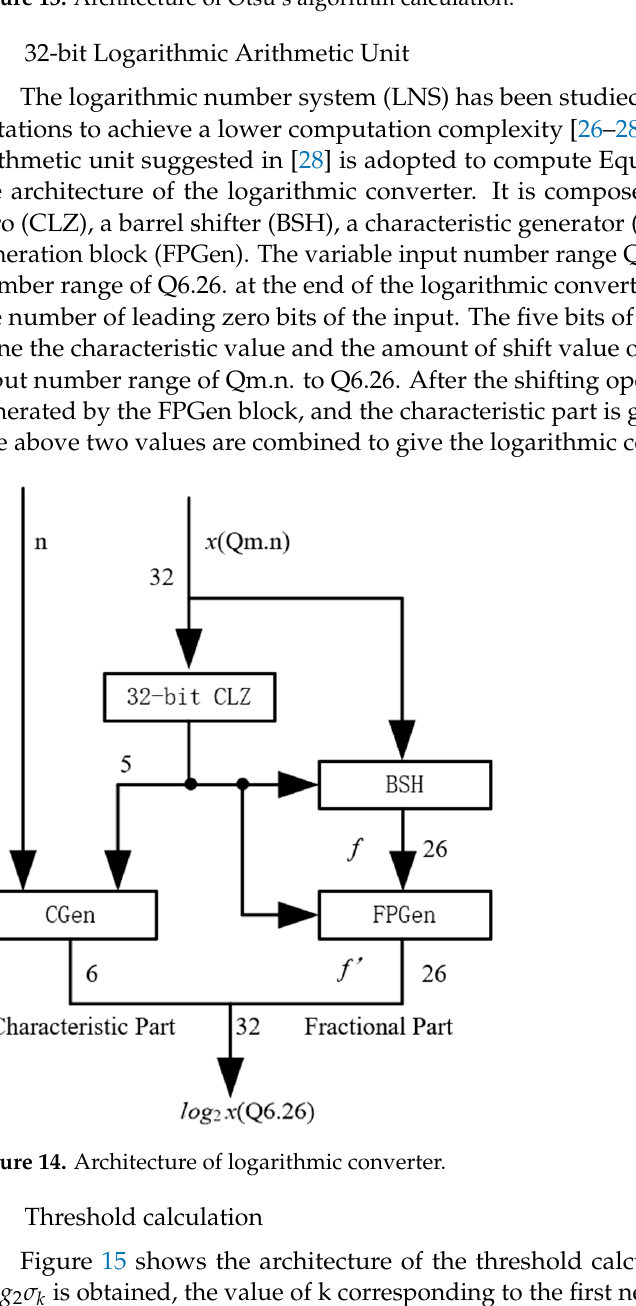
Figure 15. Architecture of threshold calculation.